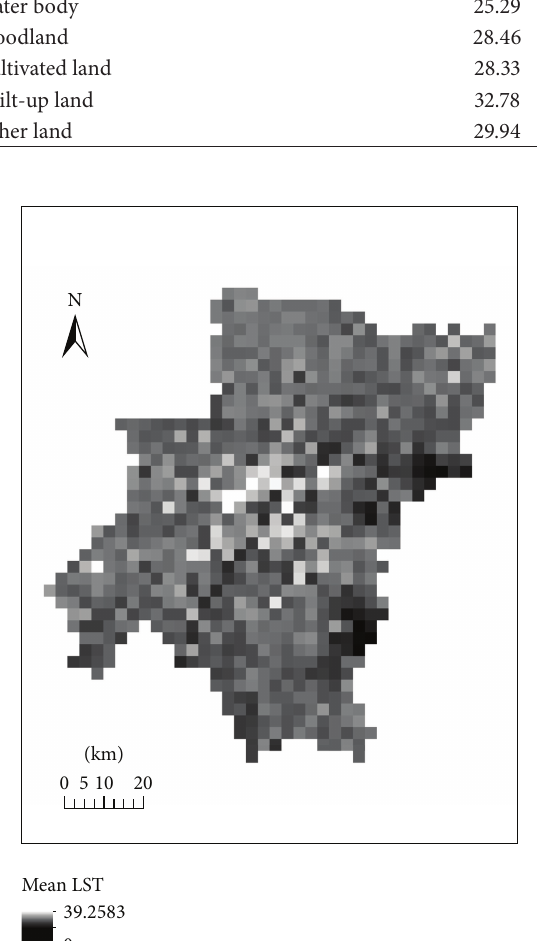
Figure 5: The mean land surface temperature in 3000 m ∗ 3000 m sample region in Wuhan